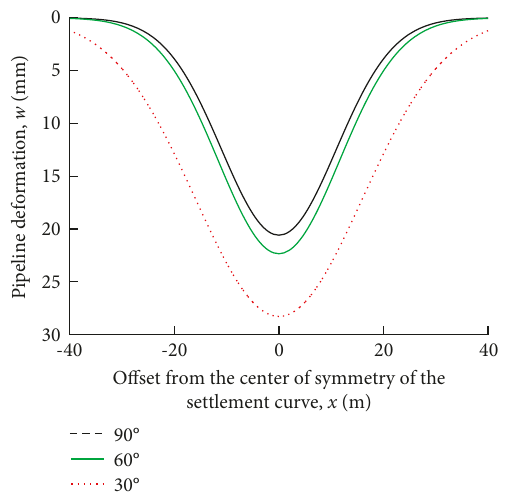
Figure 10: Pipeline deformation under different intersection